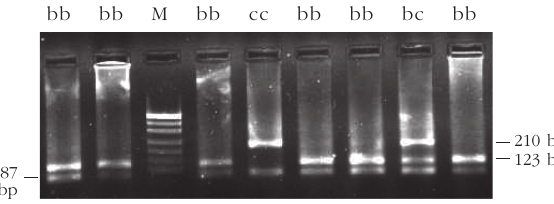
Fig 4 – Electrophoretic patterns of the second exon of Ovar- DRB 1 digested with Mva I in Kazakh sheep, M: puc 19DNA marker.